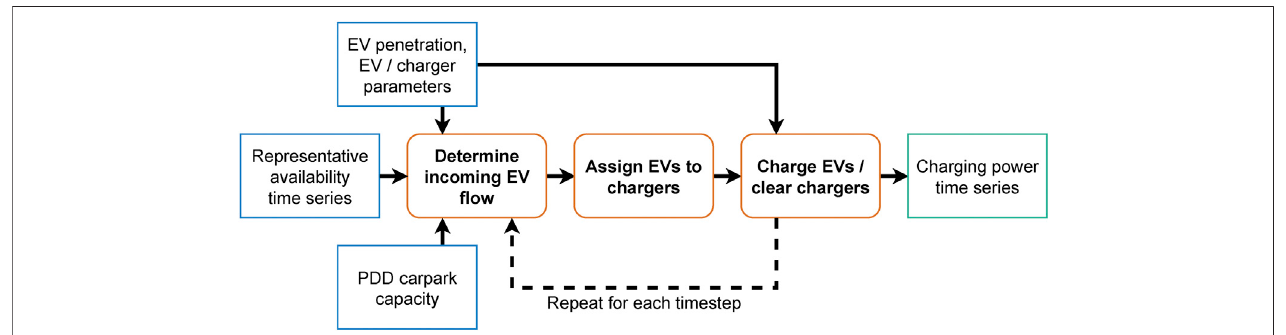
FIGURE 5 | EV car park